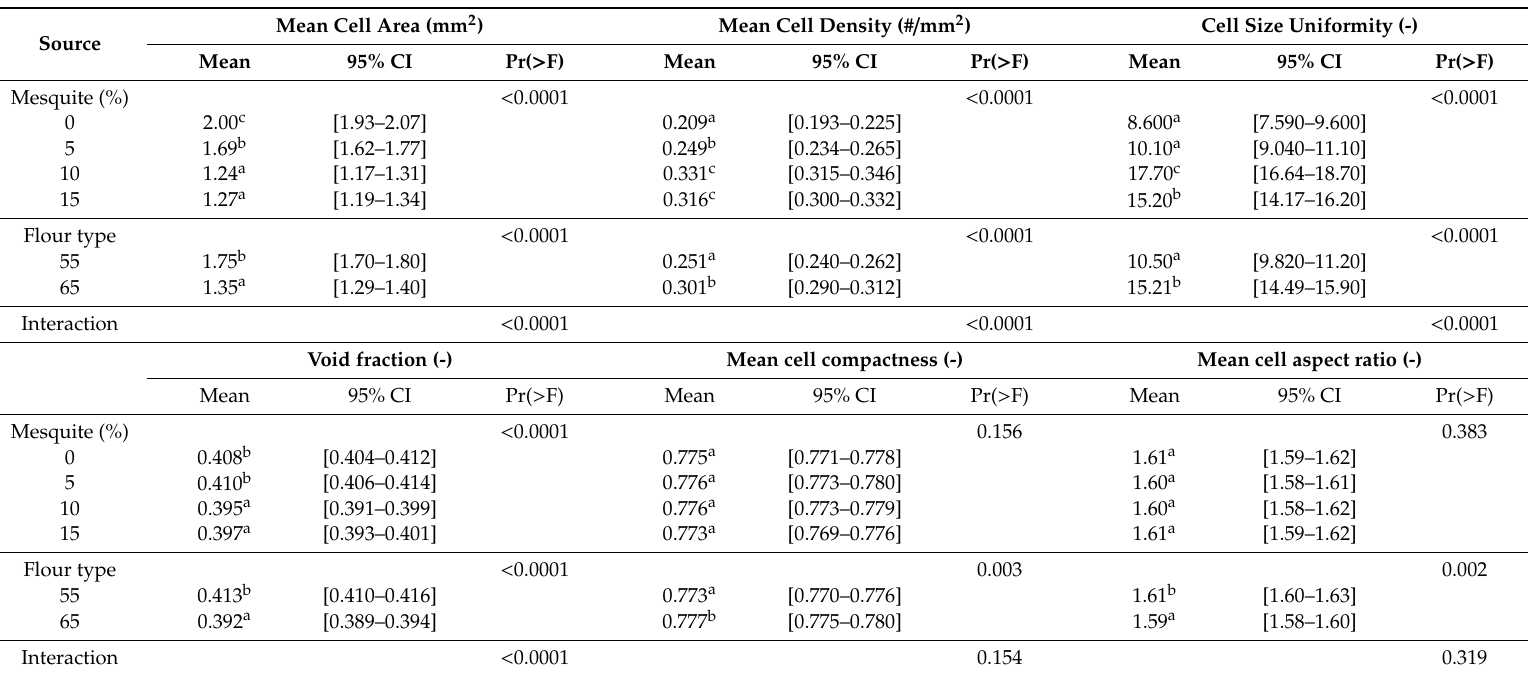
Table A4. Combined e ff ect of mesquite flour substitution level and wheat flour type on image analysis crumb features of composite bread, showing means and 95% confidence